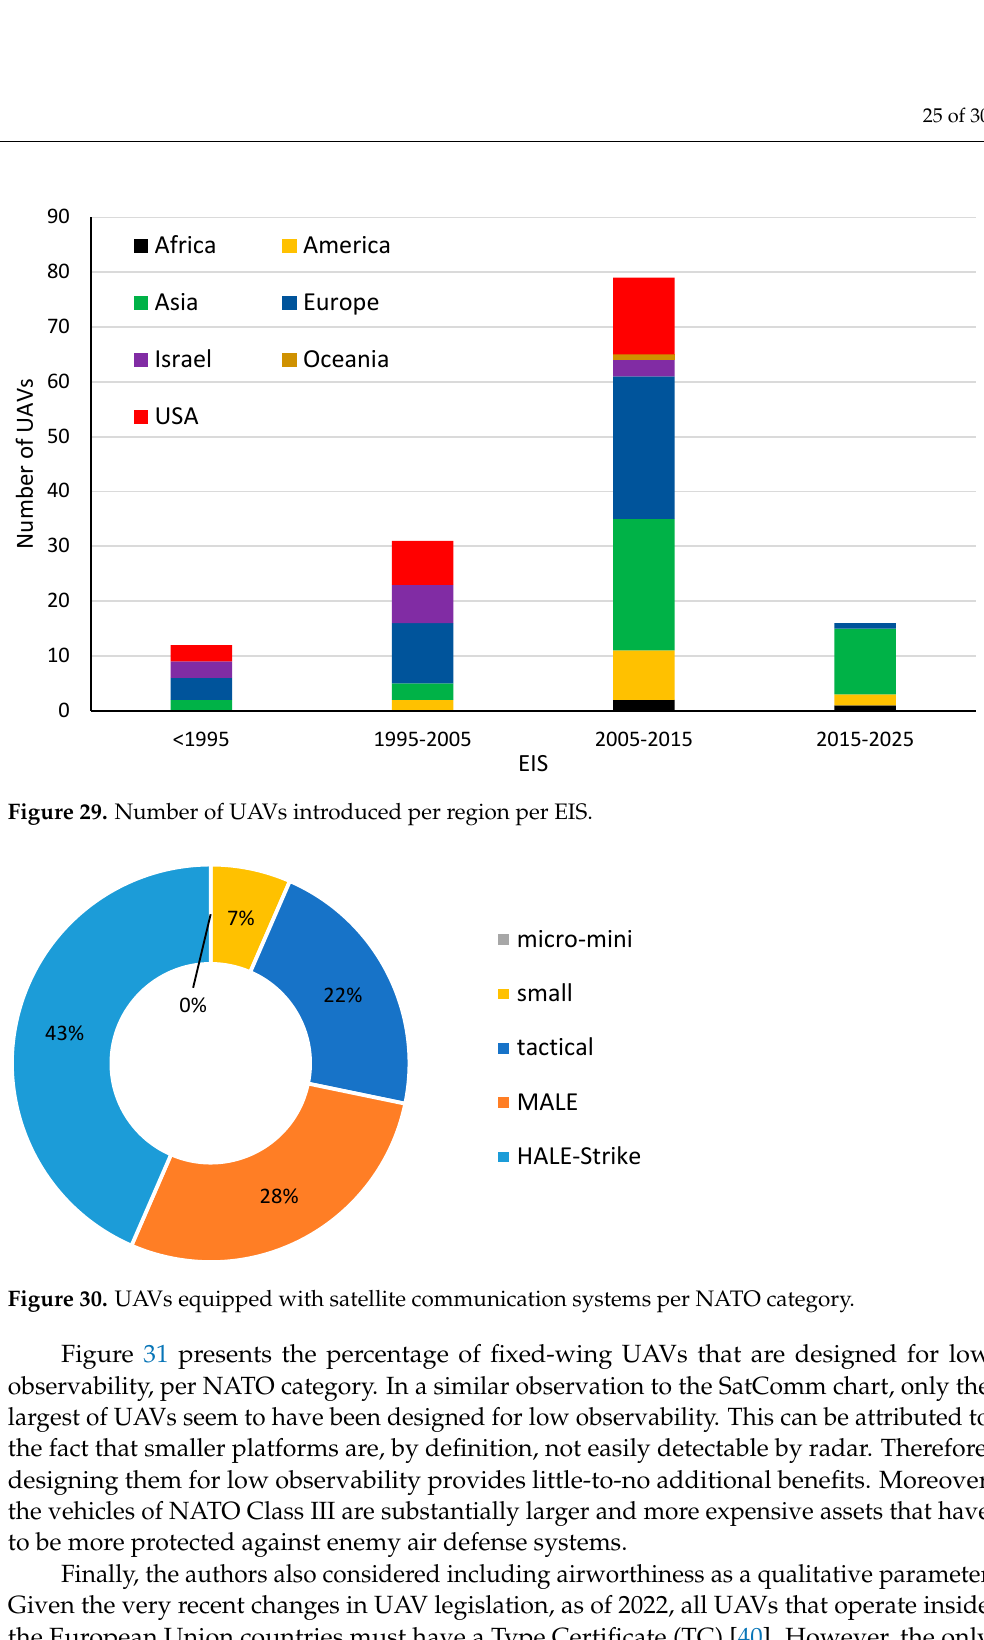
Figure 31. UAVs designed for low observability per NATO category.